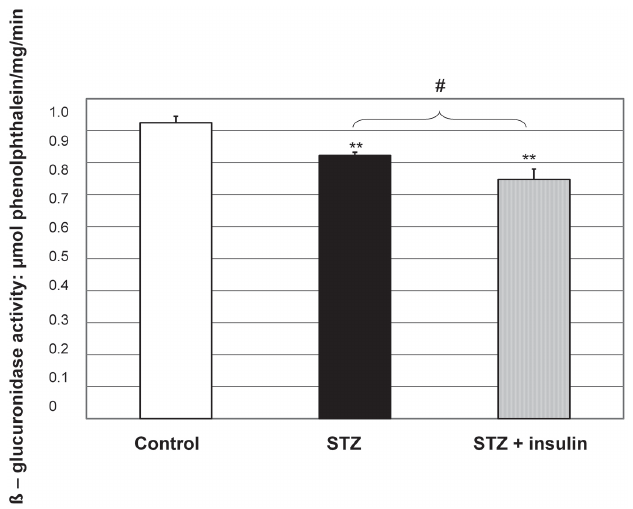
FIGURE 3 - Activity of β-glucuronidase of the liver in control and diabetic rats without or with insulin administration. Values represent the mean ± S.E. of seven rats. Significant difference from the control value: ** p<0.01. Significant difference from the value of STZ-diabetic rats without insulin administration: ## p<0.01. The columns show the amount of phenolphthalein formed from its glucuronide in 1 minute calculated for 1 mg liver protein.